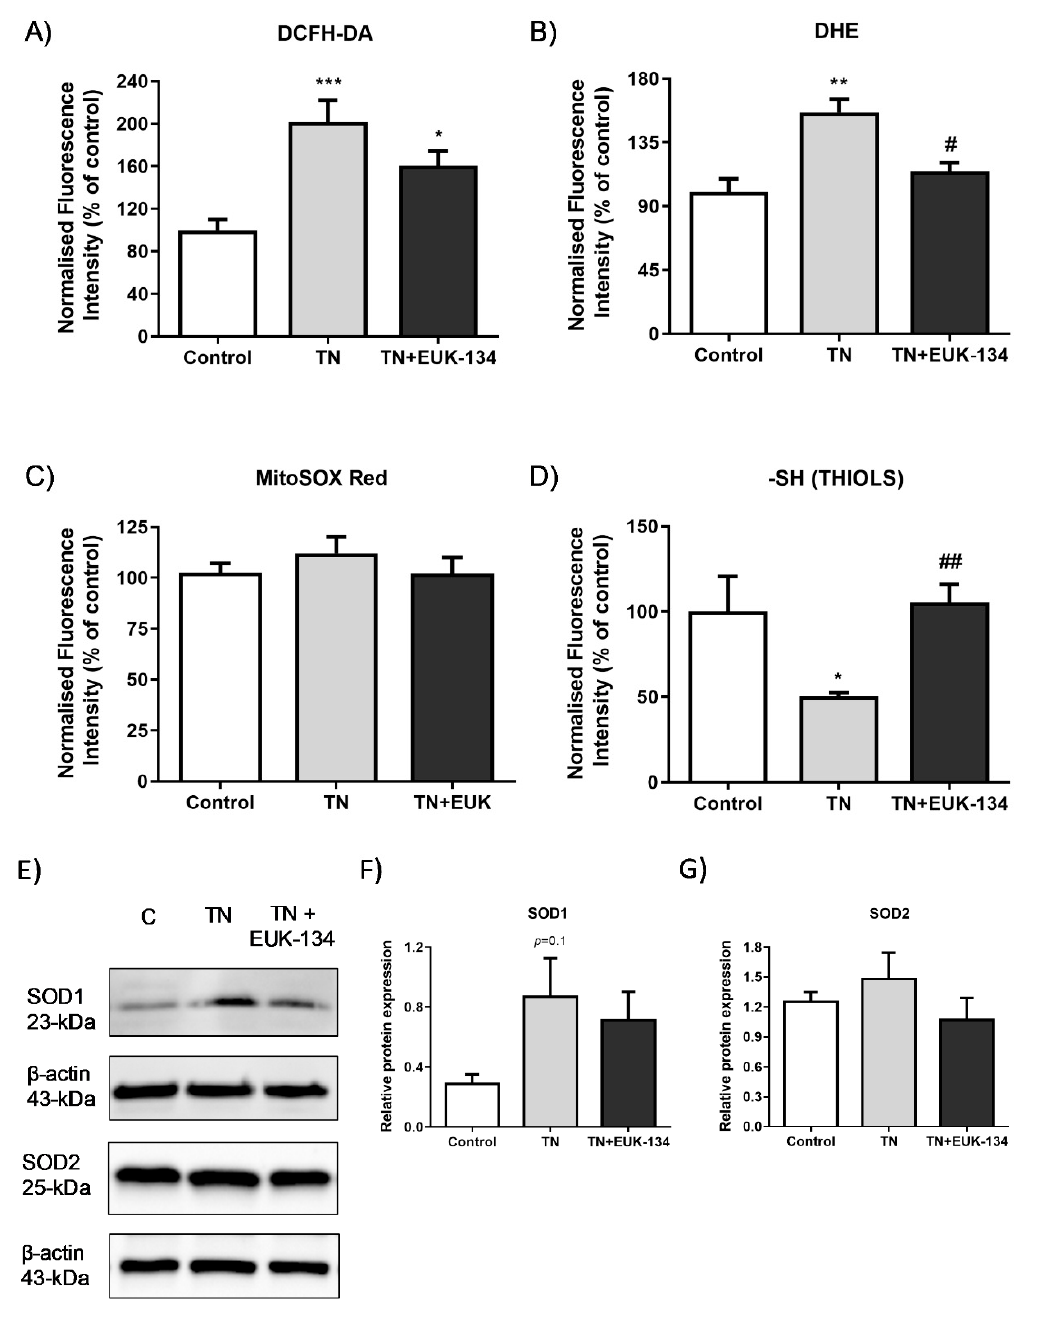
Figure 7. Markers of ROS generation in tunicamycin-treated cells with or without EUK-134. Relative change (%) in ( A ) total cellular ROS levels (DCFH-DA, n = 8), ( B ) total cellular superoxide levels (DHE, n = 4), ( C ) mitochondrial superoxide levels (MitoSOX Red, n = 20), and ( D ) total thiol content ( n = 6), normalised to protein content. Data represent the mean ± SEM, * p ≤ 0.033, ** p < 0.002, and *** p < 0.001 against vehicle control or tunicamycin alone (#). ( E – G ) Cropped representative Western blot image and quantification of SOD1 and SOD2 protein levels relative to β -actin (loading control). Data represent the mean ± SEM ( n = 3–5).